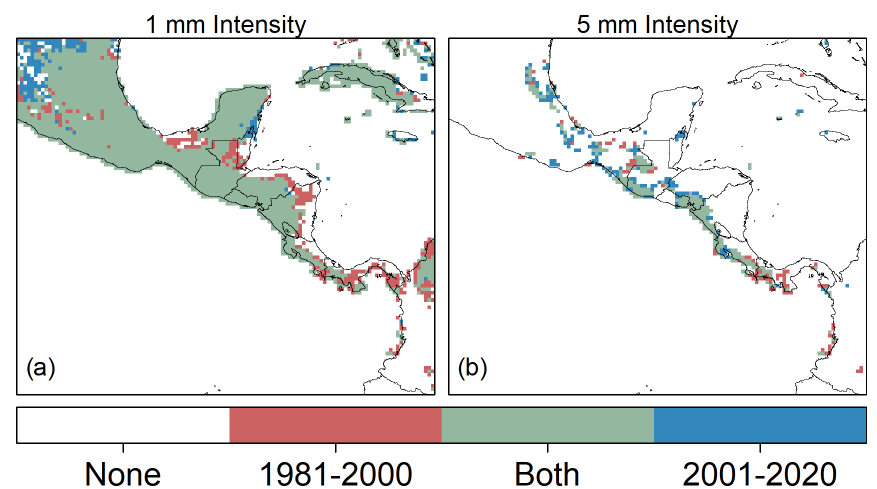
Figure 7. Pixels showing MSD by varying from the original definition the minimum required intensity from (a) 1mm and (b) 5mm.